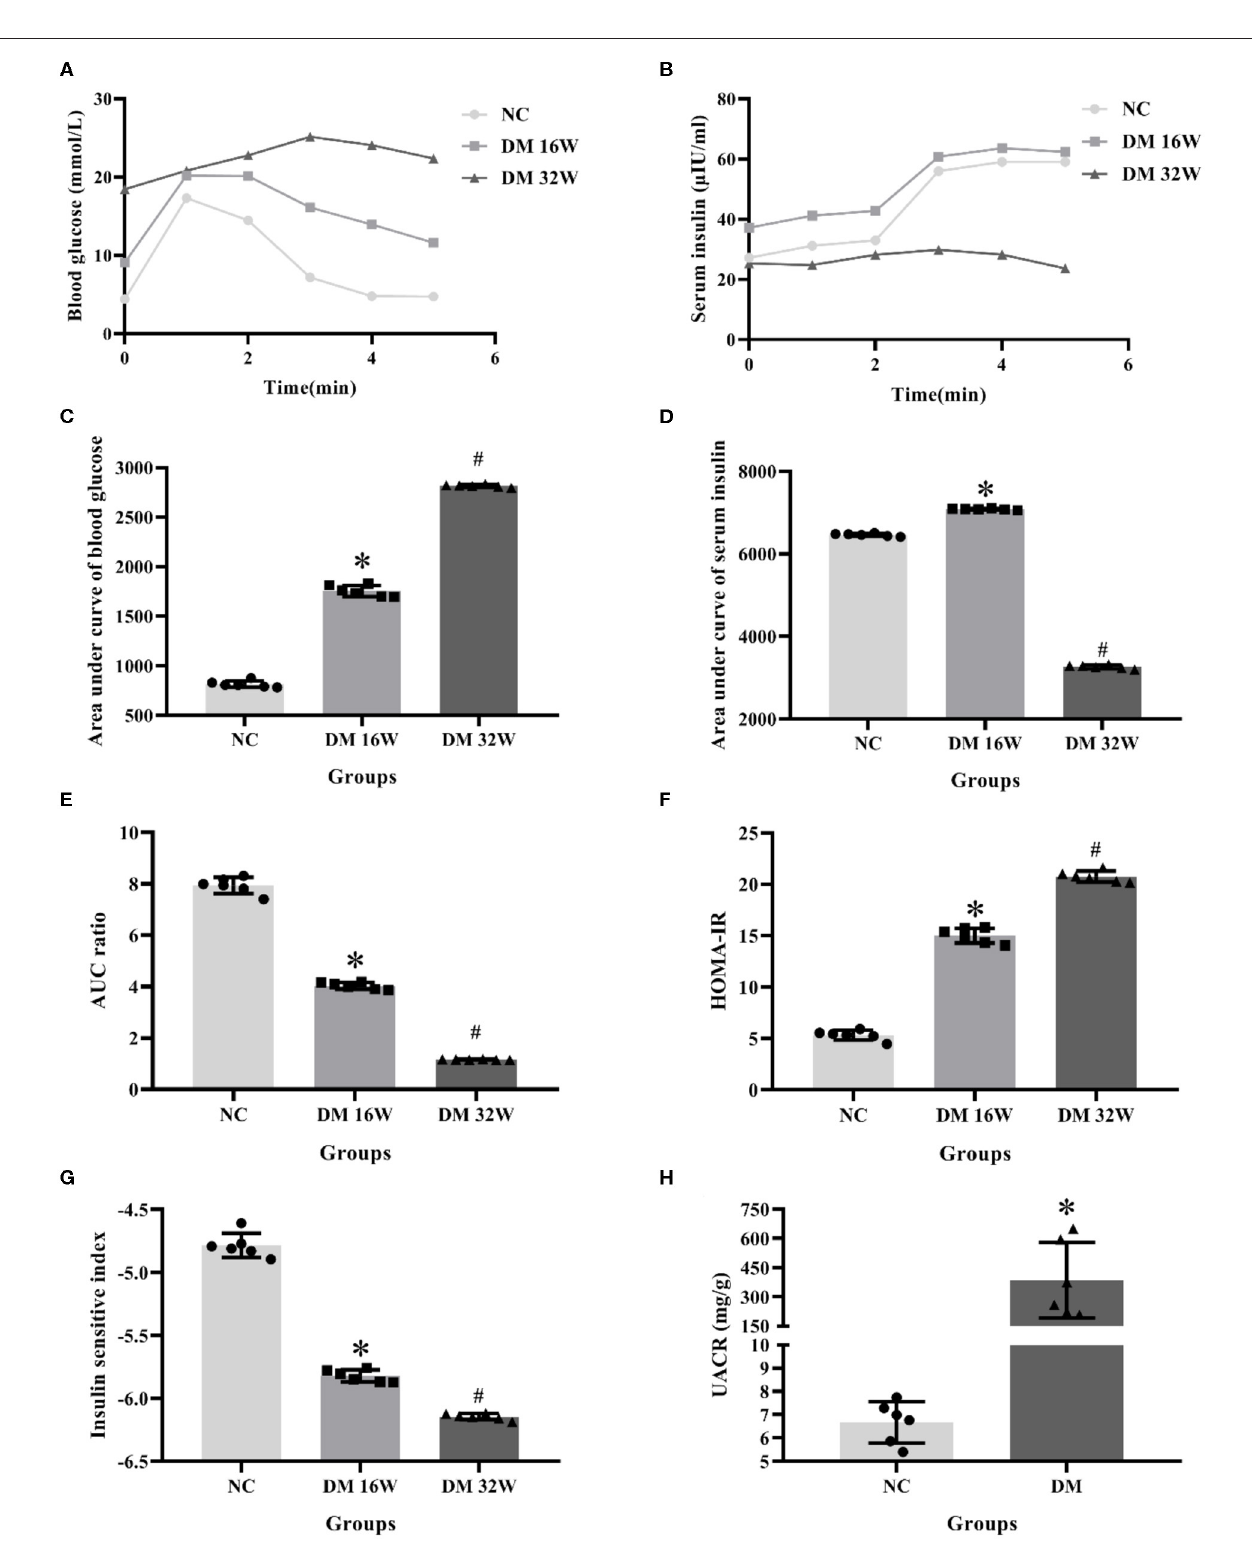
FIGURE 1 | Changes of biological indicators in rat kidney tissues. (A) IPGTT test, (B) IRT test, (C) area under curve of blood glucose (AUC GLU), (D) area under curve of serum insulin (AUC INS), (E) AUC ratio (AUC INS/AUC GLU), (F) HOMA-IR, (G) ISI, (H) UACR levels. *Compared with the NC group, P < 0.05, # Compared with the DM 16W group, P < 0.05. Data were expressed as mean ± SD, and experiments were repeated three times.